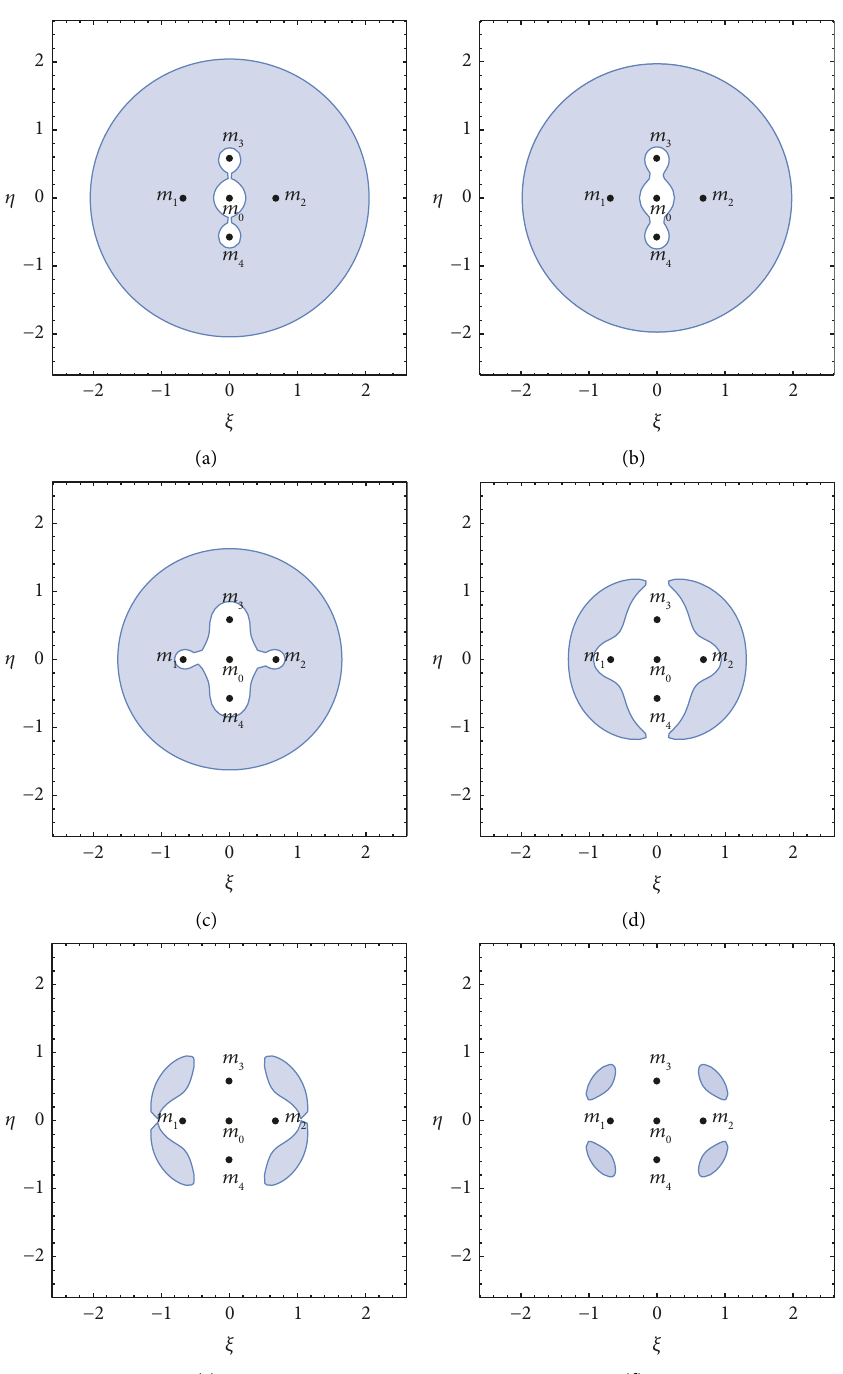
for the C ∈ (− 2 . 59 , − 1 . 54 ) when b � 0 . 58 and a � 0 . 68: 5